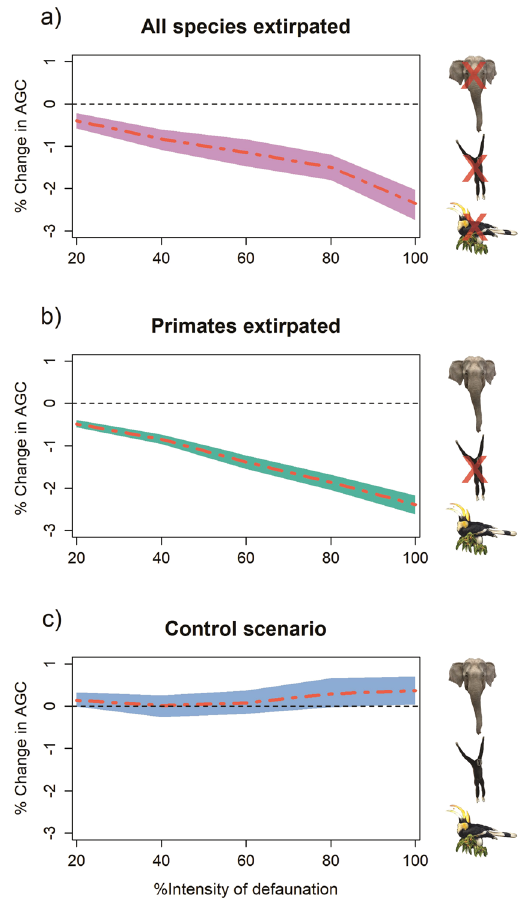
Figure 4. Percent change in above-ground carbon (AGC) storage with 95% confidence interval bands in three scenarios: ( a ) all individual trees dispersed by LBF are extirpated, ( b ) only primates are extirpated and ( c ) control scenario—all individual trees have equal chance of extirpation, across the gradient of defaunation intensity (see values in Supplementary Tables